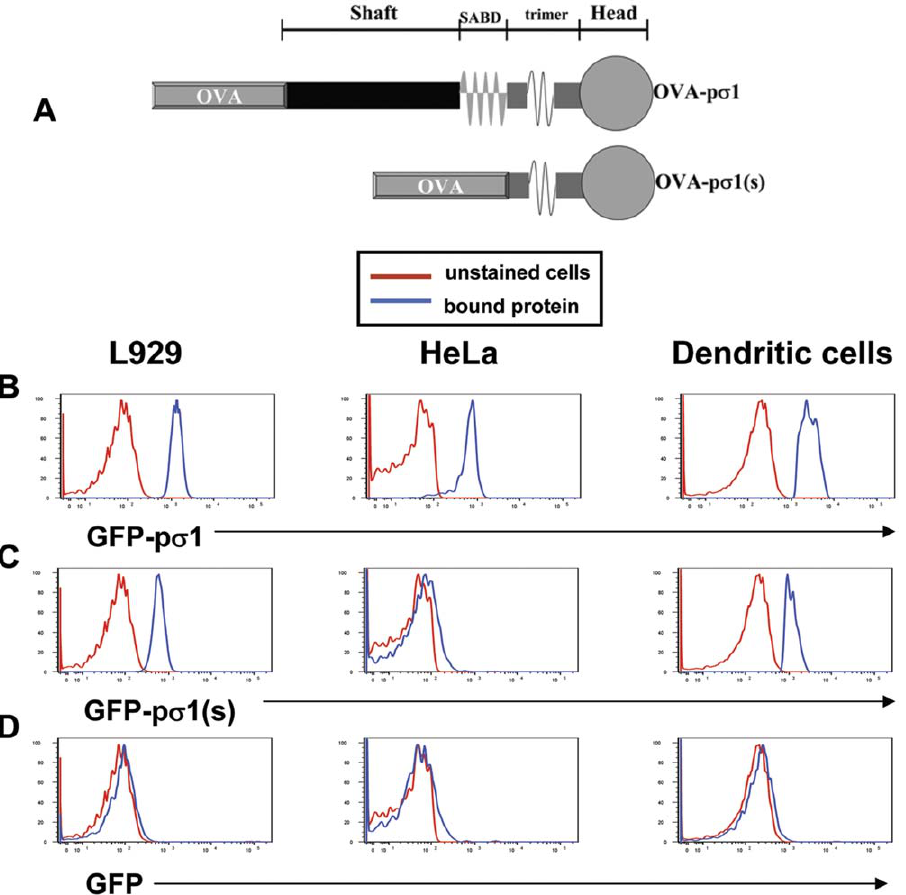
Figure 1. Deletion of p s 1’s sialic acid binding domain (SABD) eliminates HeLa cell binding capacity. A. Schematic representation of OVA-p s 1 variants: tolerogenic OVA-p s 1 (shaft, SABD, trimerization domain [trimer], and head) and OVA-p s 1(short) [OVA-p s 1(s)] lacking the SABD and shaft. Cell binding to L929 cells, HeLa cells, and dendritic cells by recombinant B. GFP-p s 1, C. GFP-p s 1(s), and D. GFP are shown. GFP-p s 1(s) bound to L929 cells and to mouse DCs, but lost capacity to bind HeLa cells (sialic acid-dependent).